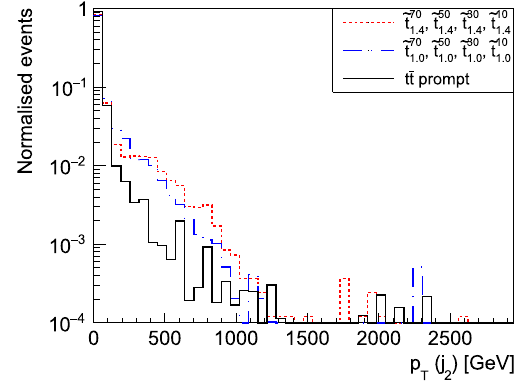
Fig. 59 Jet multiplicity N j in the stop squark ˜ t